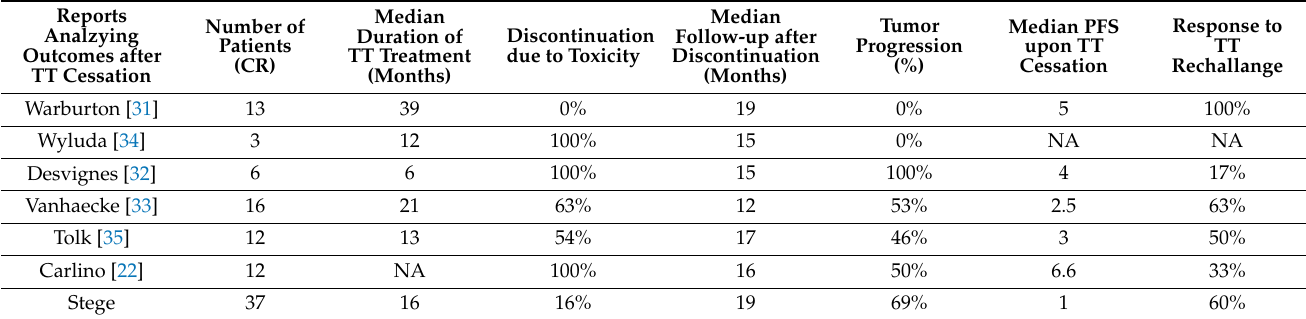
Table 3. Comparison of outcomes reported for metastatic melanoma cohorts with an initial CR to BRAFi ± MEKi therapy. Reports